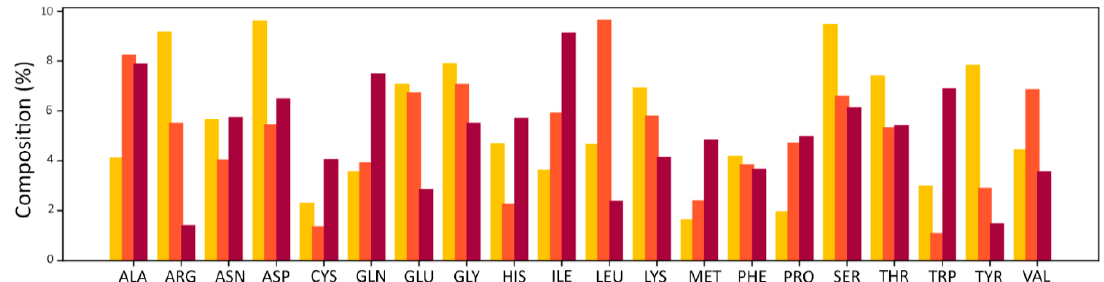
Figure 3. Amino acid composition of the binding pockets (yellow bars) with respect to that of the corresponding proteins (red bars) and that of all the known proteins in UniProt (orange bars).